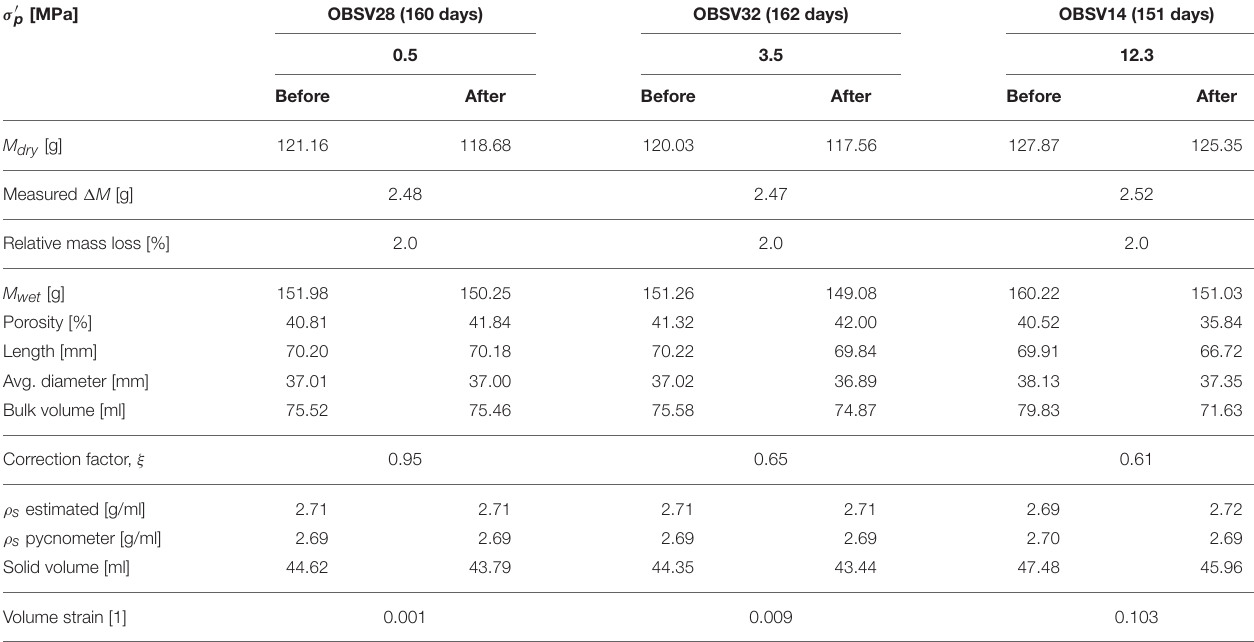
TABLE 2 | Basic quantities of the 92 ◦ C